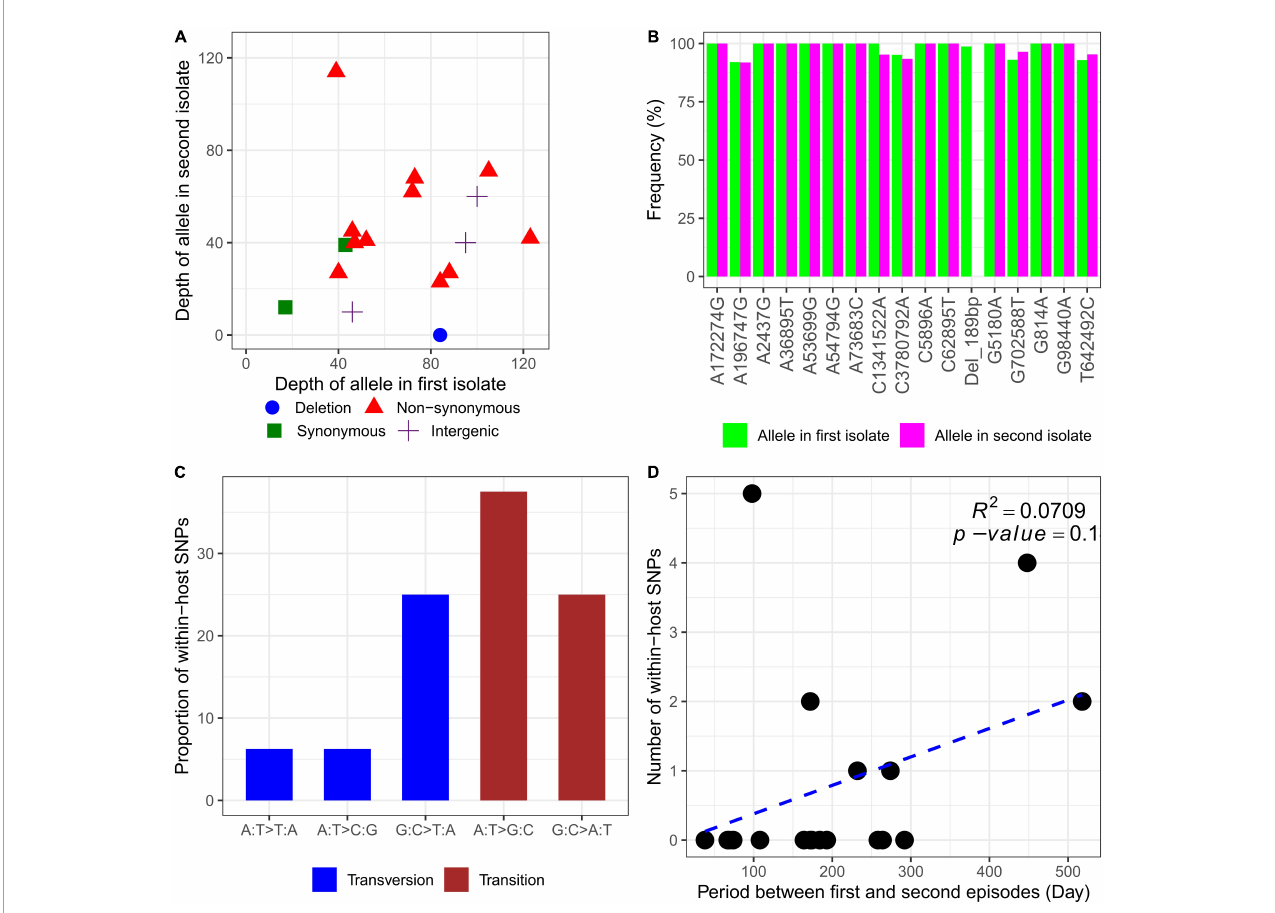
FIGURE4 Characteristics of within-host mutations. (A) Read depth of alleles in the first and second isolates. (B) Frequency of alleles in the first and second isolates. (C) Mutational spectrum of within-host SNPs. (D) Within-host SNP counts vs. time between isolates